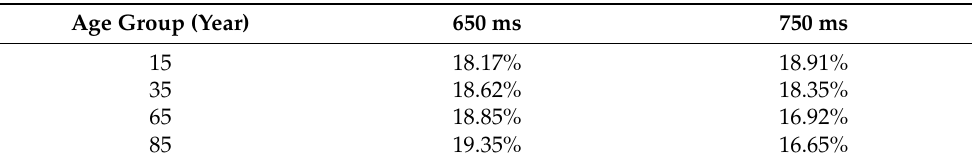
Table 2. Relative L 2 -errors between intravascular waveforms in vessel and waveforms measured on